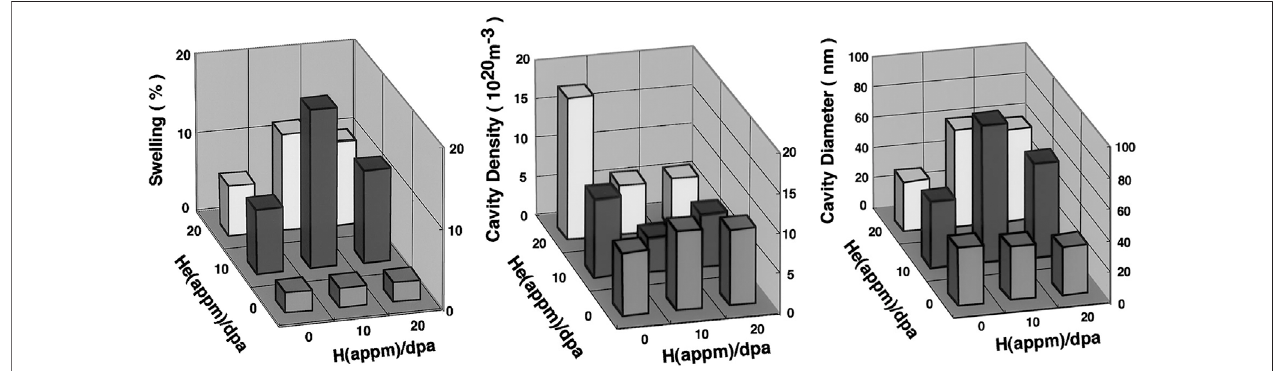
FIGURE4| Thesynergisticeffectsonvanadiumalloyirradiatedwithdifferentgas-doseratioofHeandH.Itreachedthemaximumswellingat10 appmHe/dpaand 10 appmH/dpa (Sekimura et al., 2000).